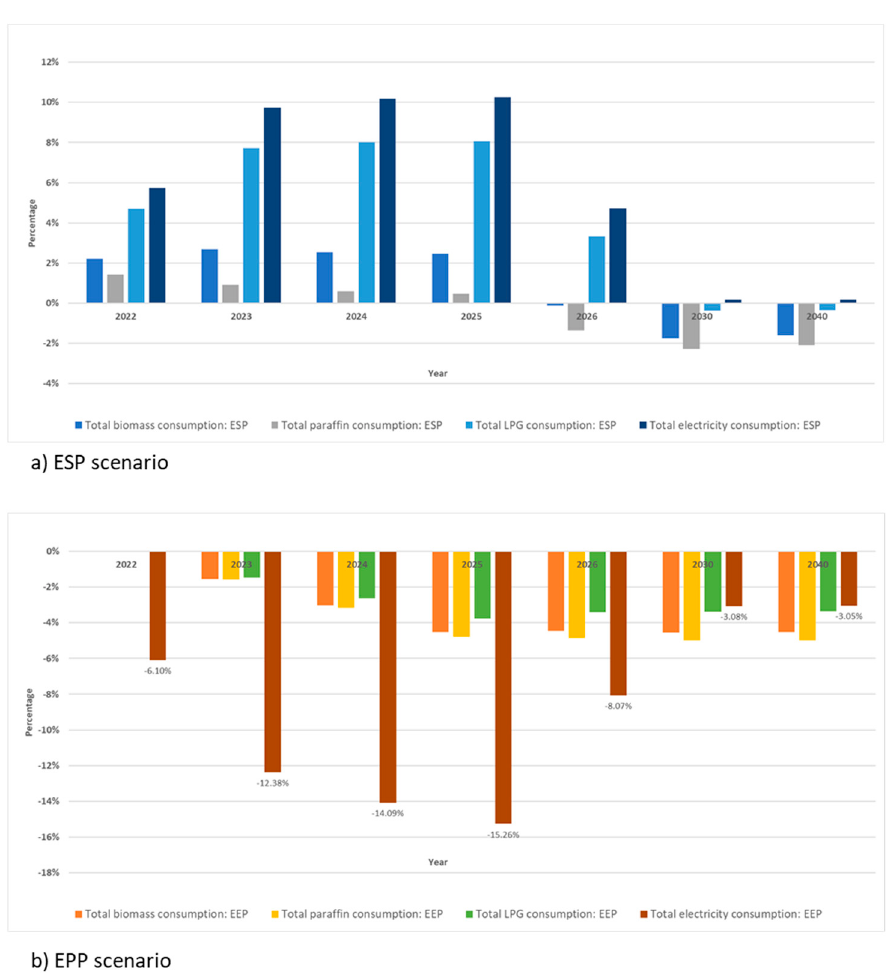
Figure 7. Percentage change in energy consumption by fuel type in the ESP ( a ) and EPP scenarios ( b ). Source: Authors.